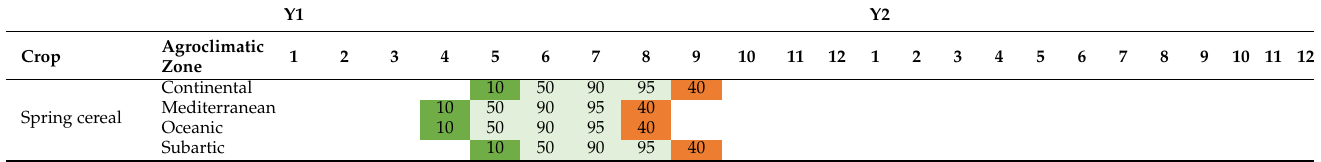
Table 2. Crop calendar and ground cover values (%) per crop and agroclimatic zone. Dark green cells indicate the start of the growing season (planting month), orange cells indicate the last month of the growing